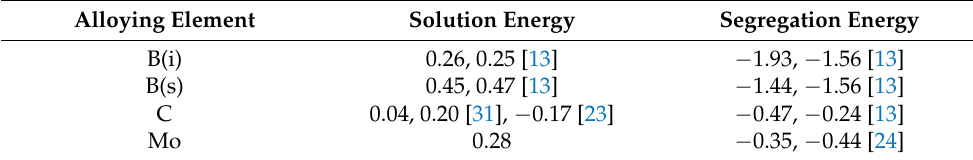
Table 2. Solution and segregation energies of alloying elements in fcc-Fe (eV).